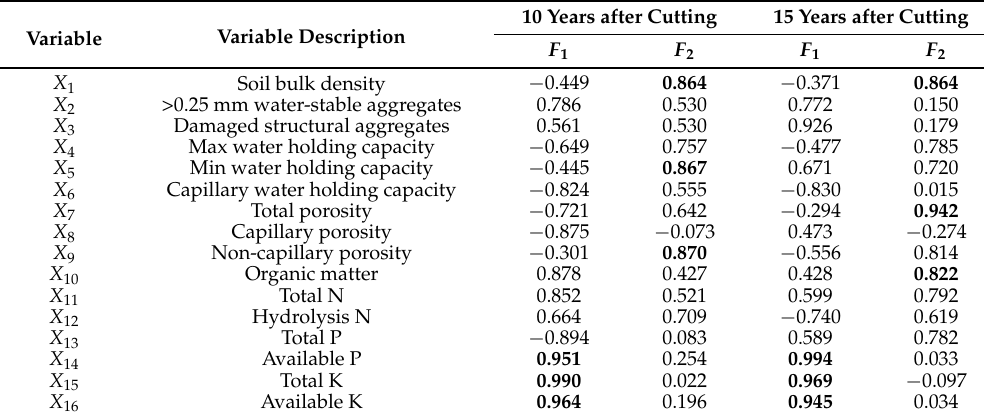
Table 10. Eigenvector coefficients for the first and second principal components.